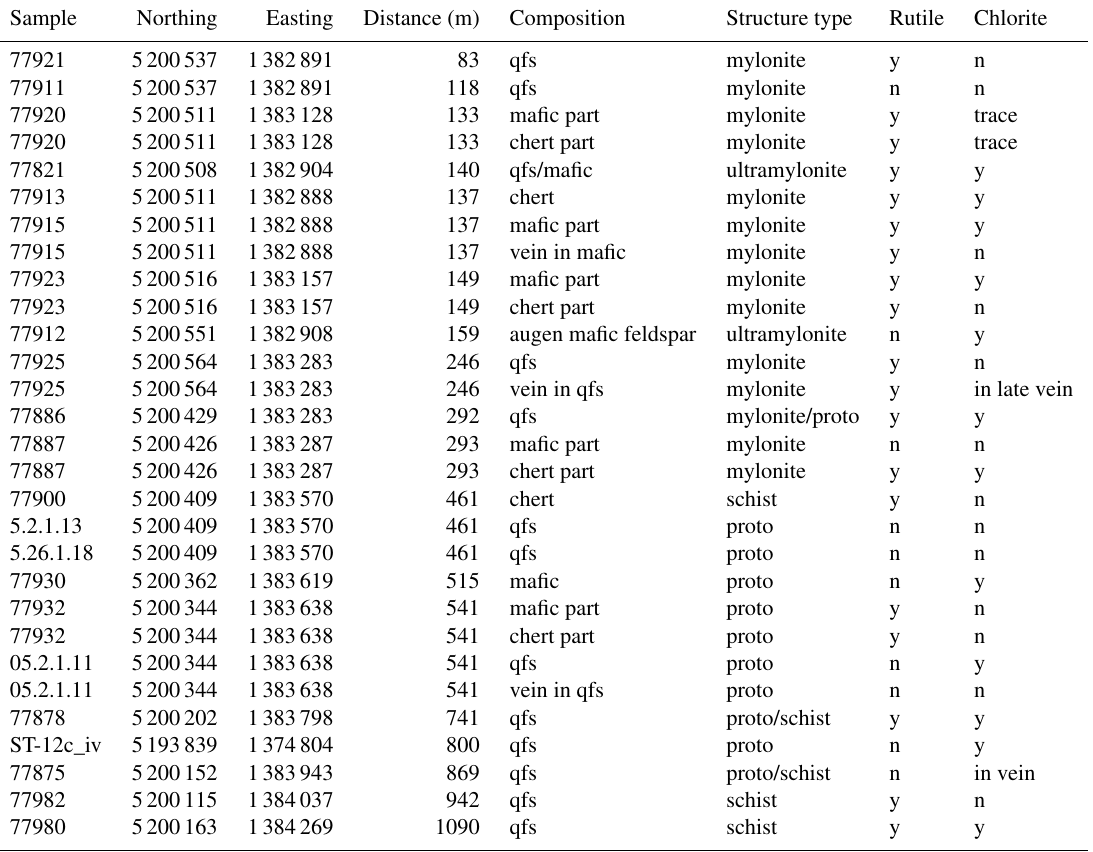
Table 1. Information on individual samples. All samples are from Gaunt Creek with the exception of Stony Creek sample ST-12c_iv. GPS data use the New Zealand Transverse Mercator Projection 2000. Distances are estimated structural distances measured perpendicular to foliation. Rutile and chlorite columns indicate whether these minerals were observed (“y”) or not (“n”). Samples identified by numbers 77*** are archived in the Otago University collection; qfs: